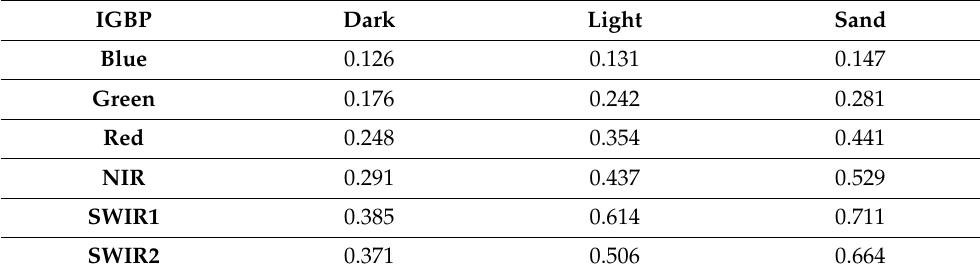
Figure 7. Banded NIR reflectance of barren classified pixels separated by continent in MODIS units (reflectance × 1000). Note that South America and Asia can be grouped together to make a dark soil group, Australia into a light soil type, and Africa into a sand type. Table 3. Average banded reflectance for barren land cover